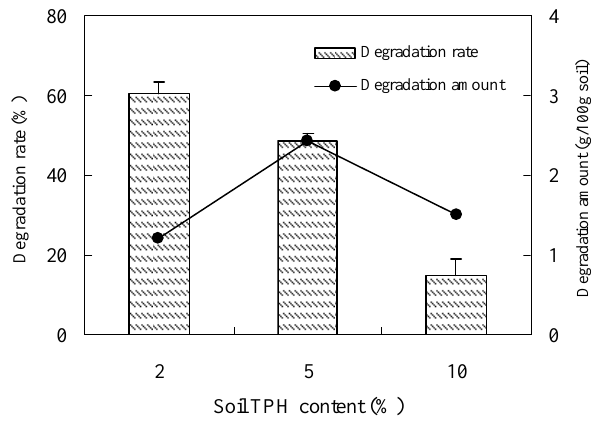
Fig. 4. The effect of EMA and PGPR bacteria on the remediation